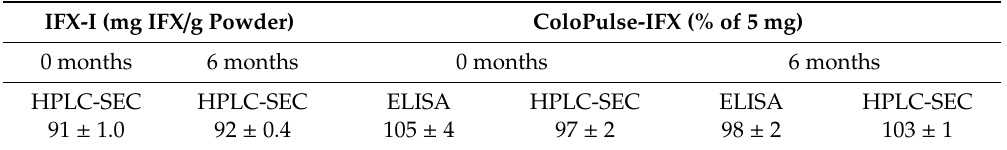
Table 5. The average ± SD preliminary stability data of IFX-I ( n = 3) and ColoPulse-IFX ( n = 3) stored in polypropylene containers at 25 ◦ C / 60% RH conform ICH guidelines